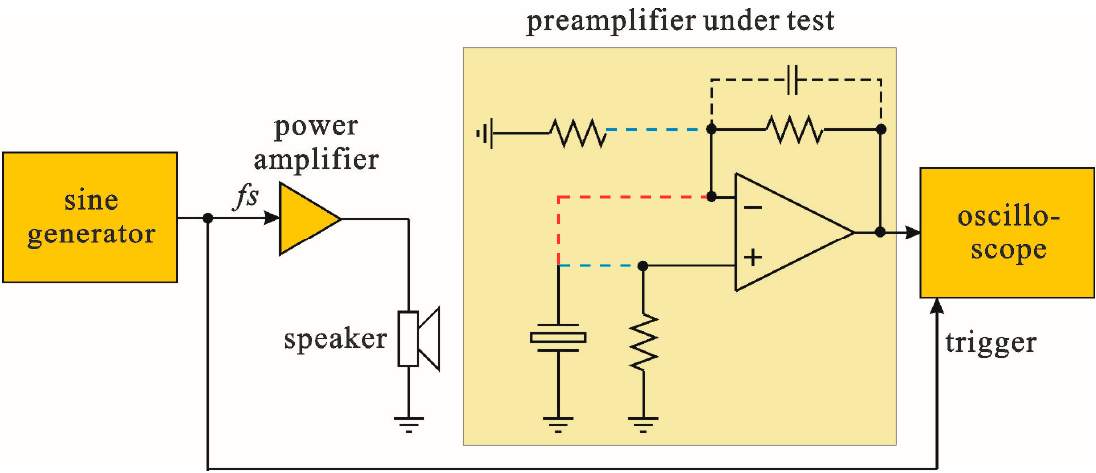
Figure 9. Block diagram of a system used for experimental verification of the preamplifier configurations (voltage, charge and transimpedance).